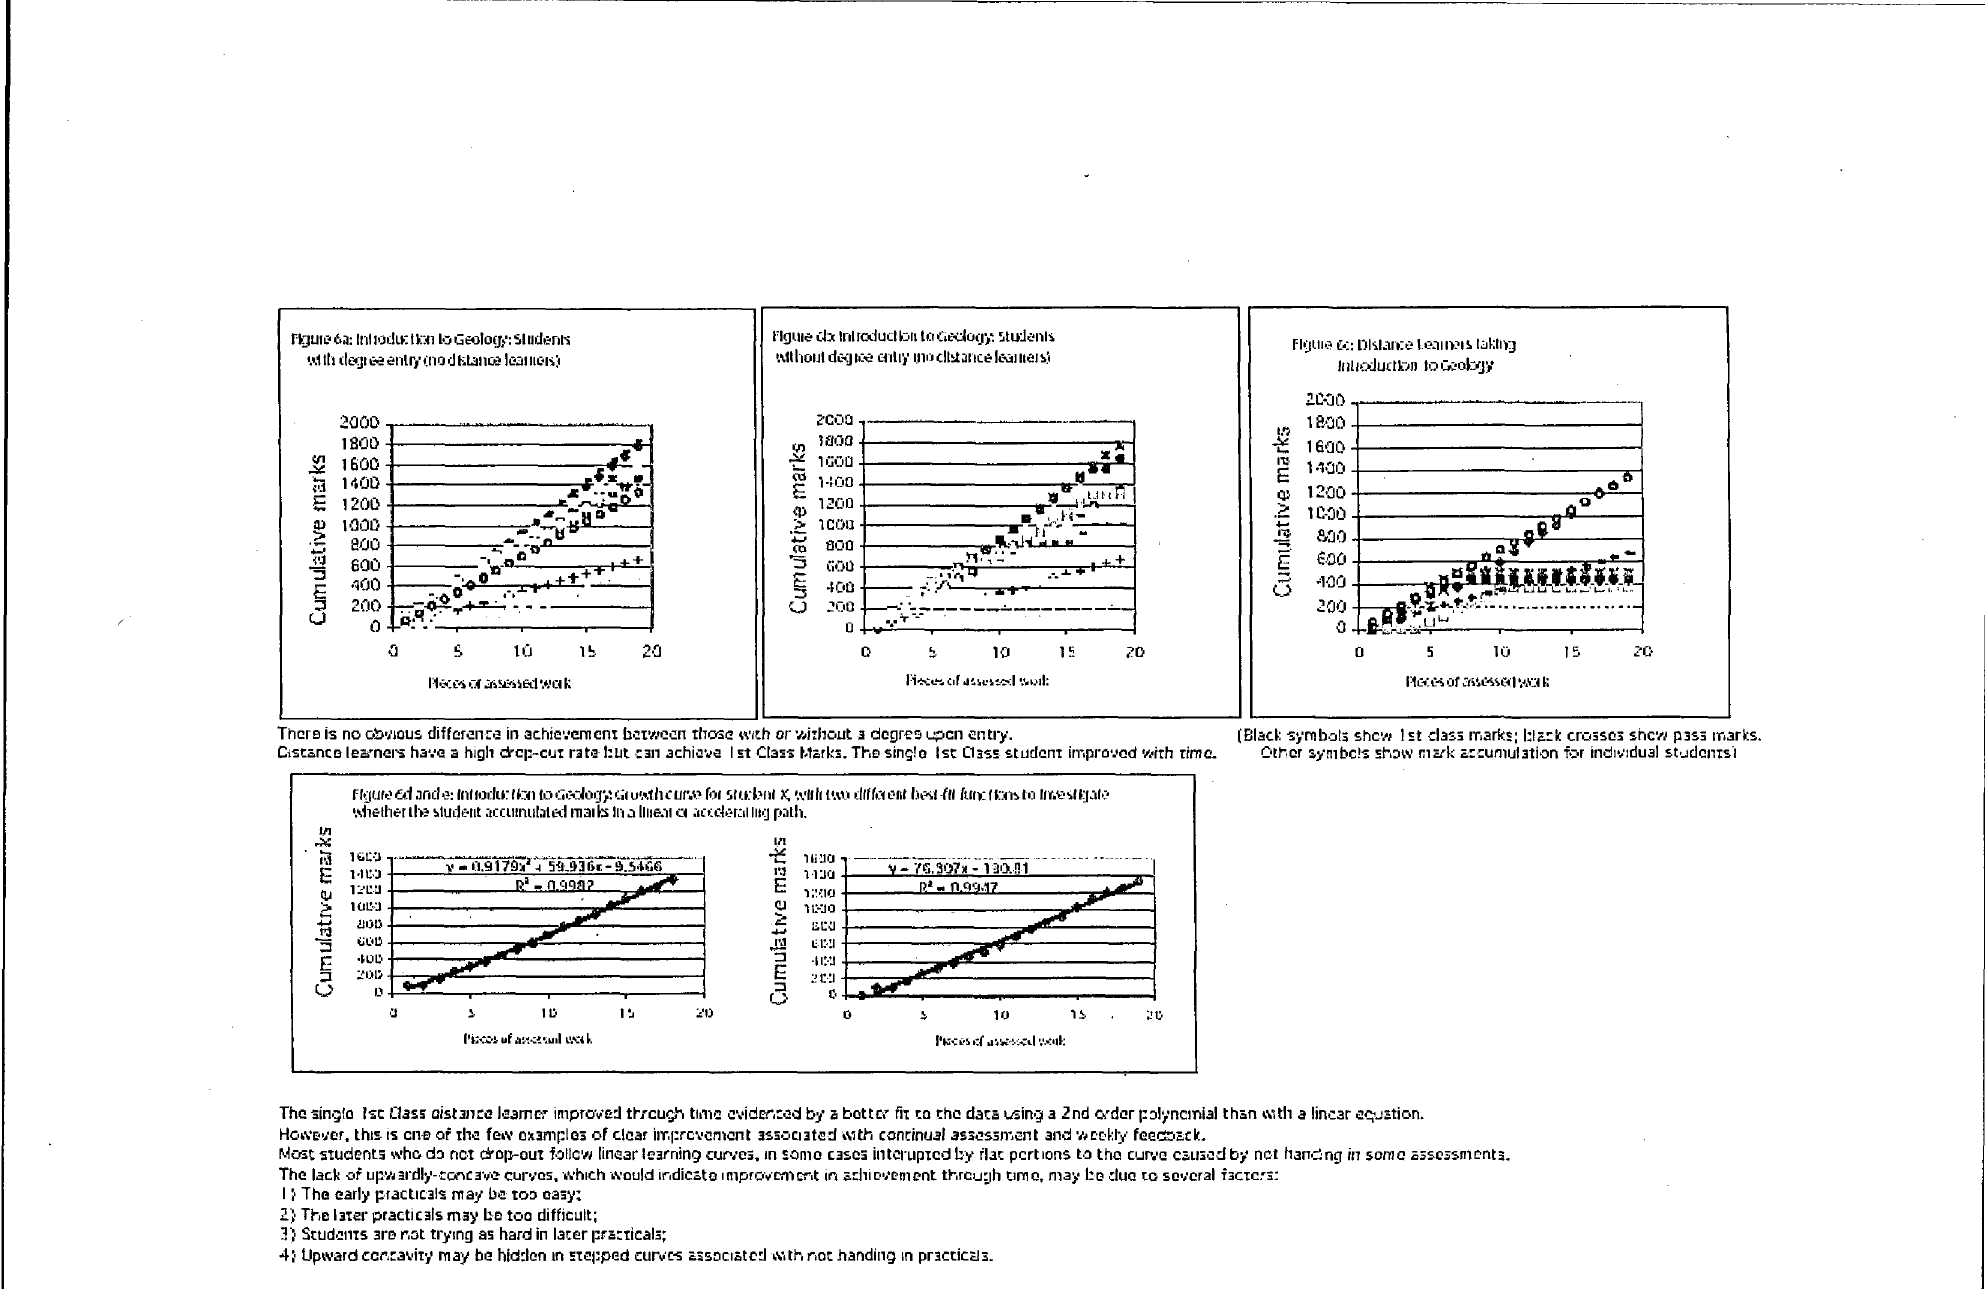
(Black symbols shew I st class marks; bls:k crosses shew p3ss marks. CistoncQ lesrners have a high drop-cut rate but can achieve 1st Class Msil.-s. Thosin^lo 1st Oass student improved with time. Other symbols :HDW nia-k zz cumulation for individual